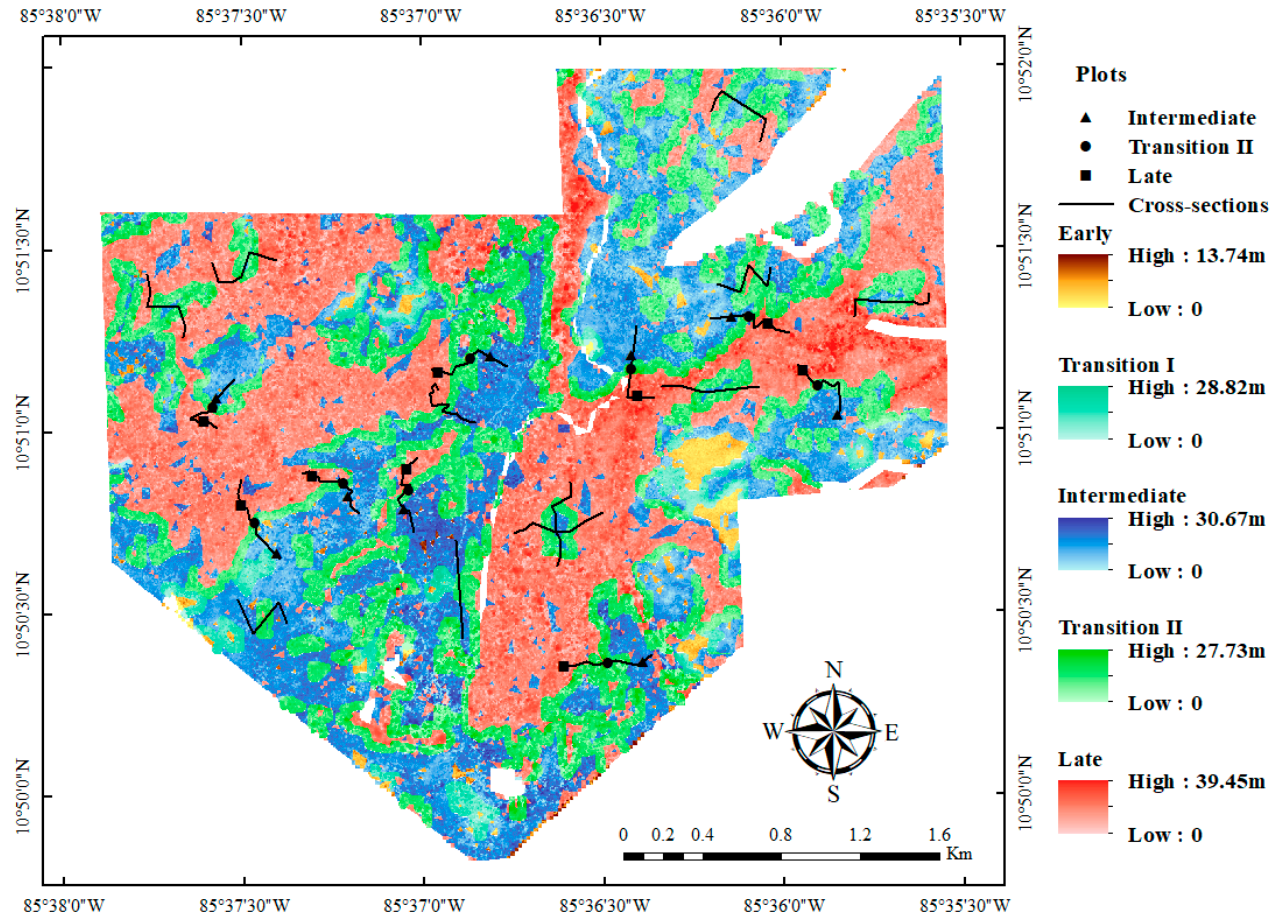
Figure 3. A canopy height model with a 5 m × 5 m spatial resolution derived from Airborne LiDAR data and the spatial distribution of three successional stages and two transitions at the SRNP-EMSS, Guanacaste, Costa Rica. The range is the overlapping between the forest cover map [23] and full-waveform LiDAR data (Figure 2d). Twenty cross-sections (black lines) of 500 m in length and twenty-seven plots (nine for each successional stage) with an area of 45 m × 45 m along the successional gradient were extracted randomly and evenly over the study area.